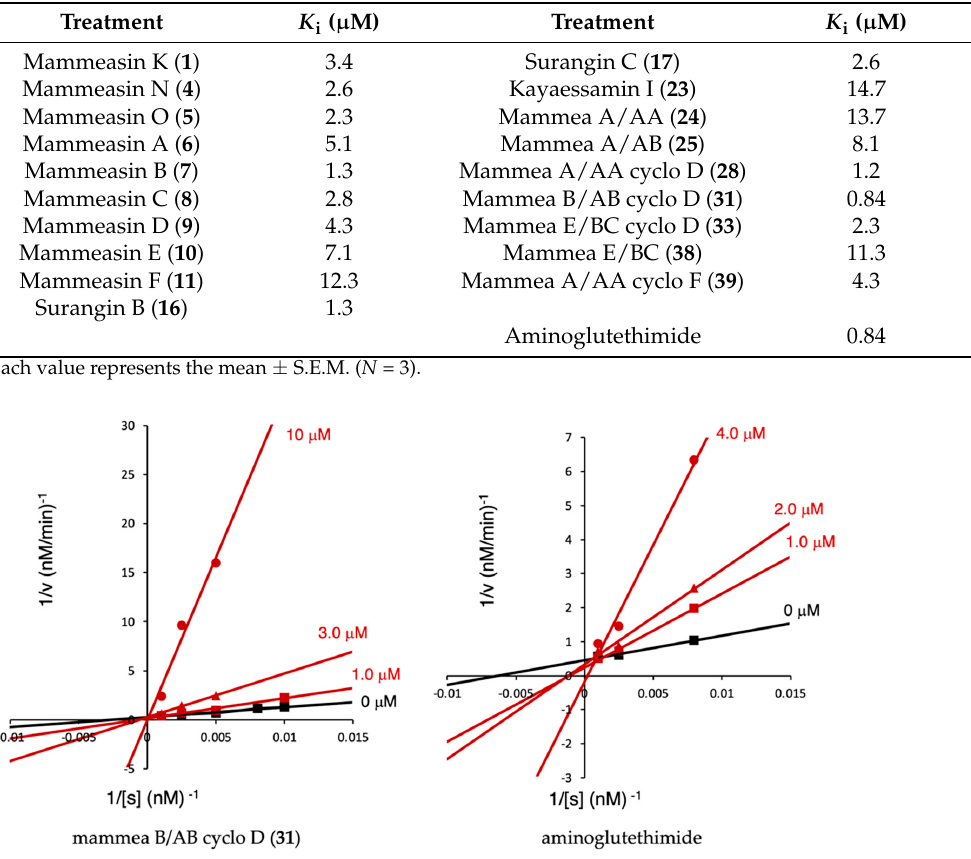
Table 6. K i values of coumarin constituents ( 1 – 11 , 16 , 17 , 23 – 25 , 28 , 31 , 34 , 38 , and 39 ) from the flowers of M. siamensis against human recombinant aromatase.